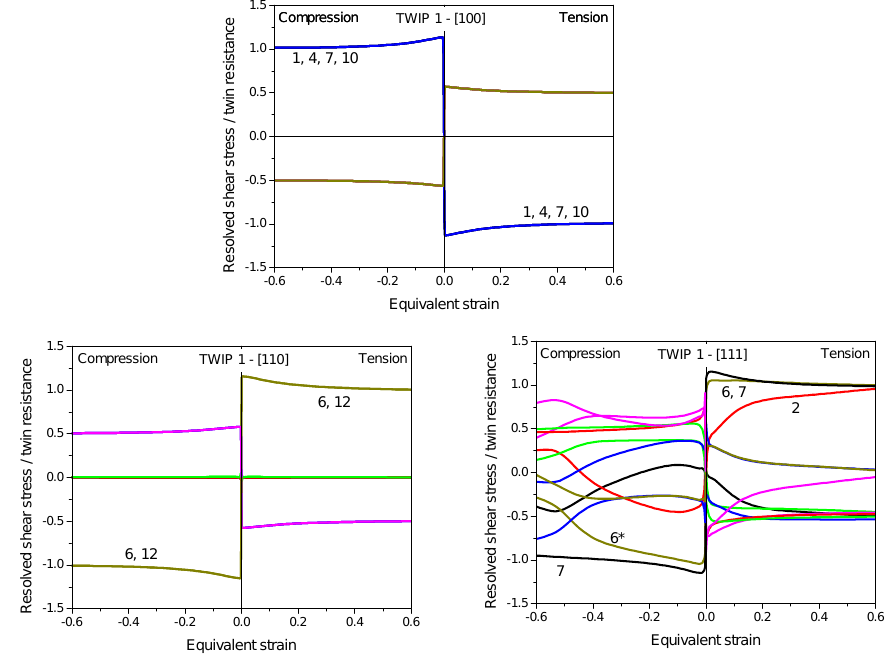
Figure 7. Activity of twin planes in single crystal of TWIP 1, TWIP 2, and TWIP 3 steels under tension and compression in three crystallographic